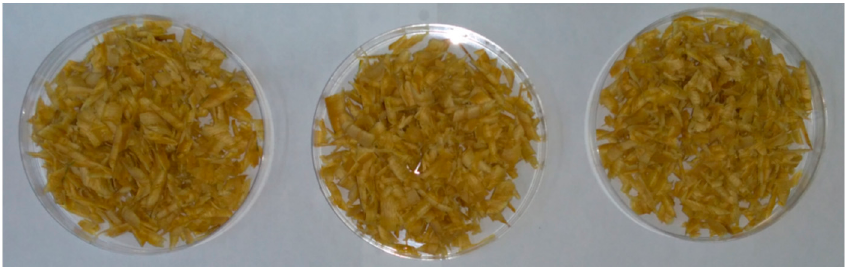
Figure 1. Thin wood samples used in the tests.